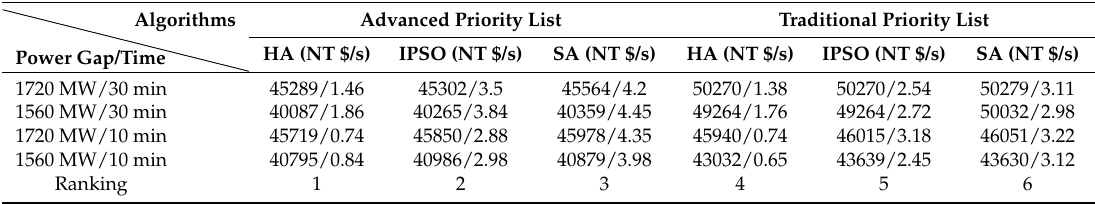
Table 6. Comparison of the results of three algorithms in different renewable energy gap and time scenarios.